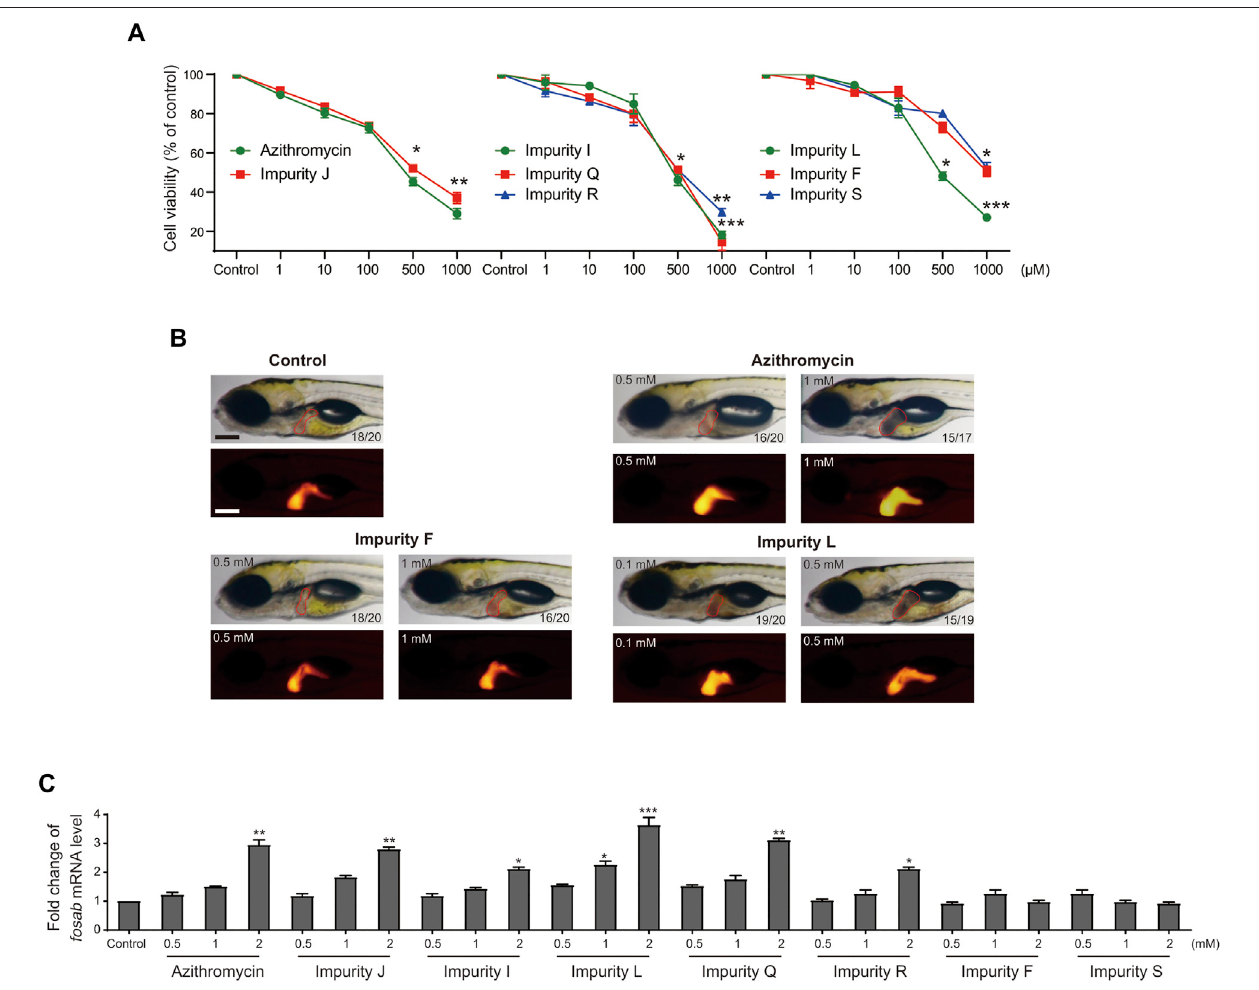
FIGURE6| Analysisofthelivertoxicityofazithromycinimpurities invitro and invivo . (A) CellviabilityofL02 cellsafterexposedtoazithromycinand impurities J,I,L, Q, R, F, and S solutions were tested by CCK-8 assay. Control indicates 0.1% DMSO-treated group. * indicates p < 0.05, ** indicates p < 0.01, ***indicates p < 0.001 compared with the control group. All values are expressed as the mean ± SD ( n = 3). (B) Visual phenotype of liver toxicity in zebra fi sh larvae at 6 dpf after azithromycin, impurities F and L treatment. Representative images of treated larvae by using a light microscopic (red outline) and a fl uorescence microscopic (red fl uorescence). The digit on the bottom right corner shows the ratio of positive images. Scale bar, 250 μ m. (C) fosab mRNA levels in zebra fi sh exposed to azithromycin and its seven impurities,respectively,weredetected byqRT-PCRanalysis.Control,vehicle-treatedgroupwith0.1%DMSO, *indicates p < 0.05,*indicates p < 0.01,***indicates p < 0.001. All statistical data are represented as mean ± SD ( n =